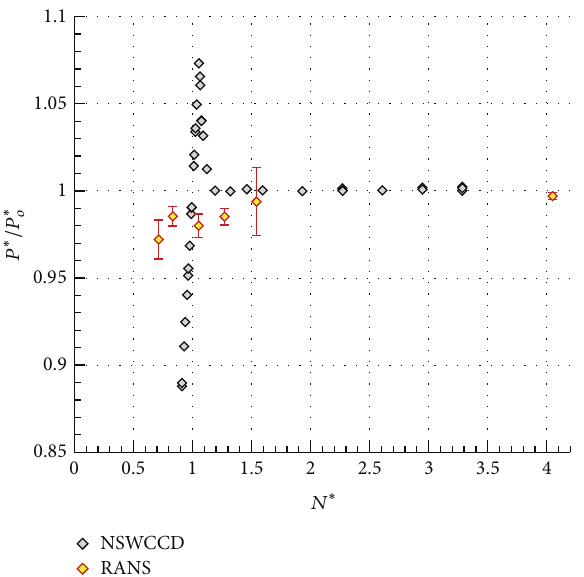
Figure 4: Cavitating RANS predictions ( 𝑃 ∗ ) compared to experi- mental measurements at NSWCCD. Note: error bar +/− represents standard deviation ( 𝜎 ) of the 𝑃 ∗ time series.